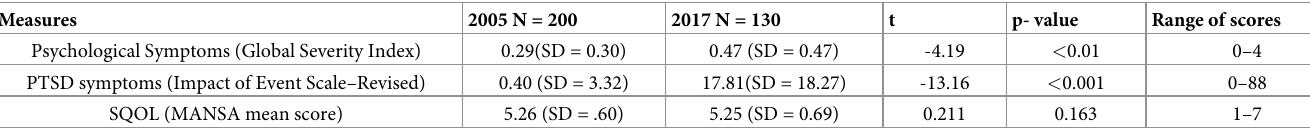
Table 1. Mean scores of general psychological symptoms, PTSD symptoms and subjective quality of life in 2005 and 2017. Measures Psychological Symptoms (Global Severity Index) PTSD symptoms (Impact of Event